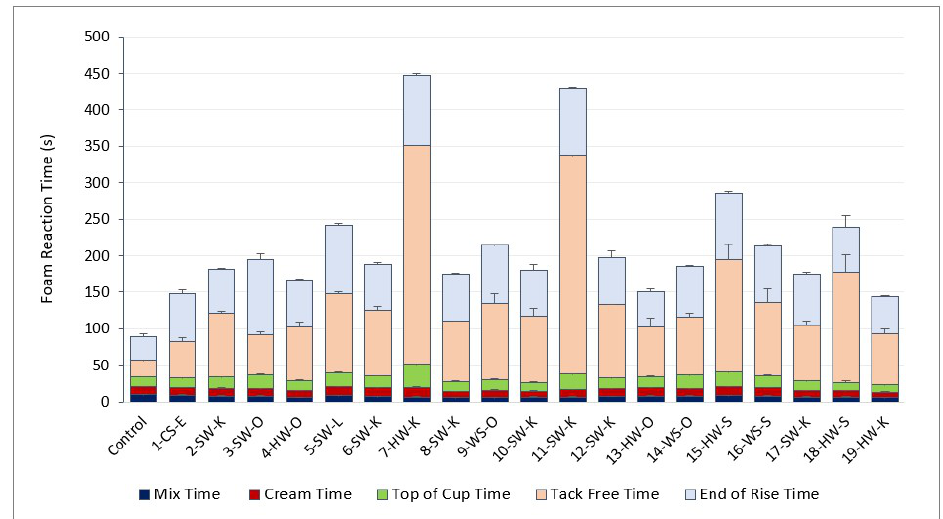
Figure 1. Foam reaction time in seconds.